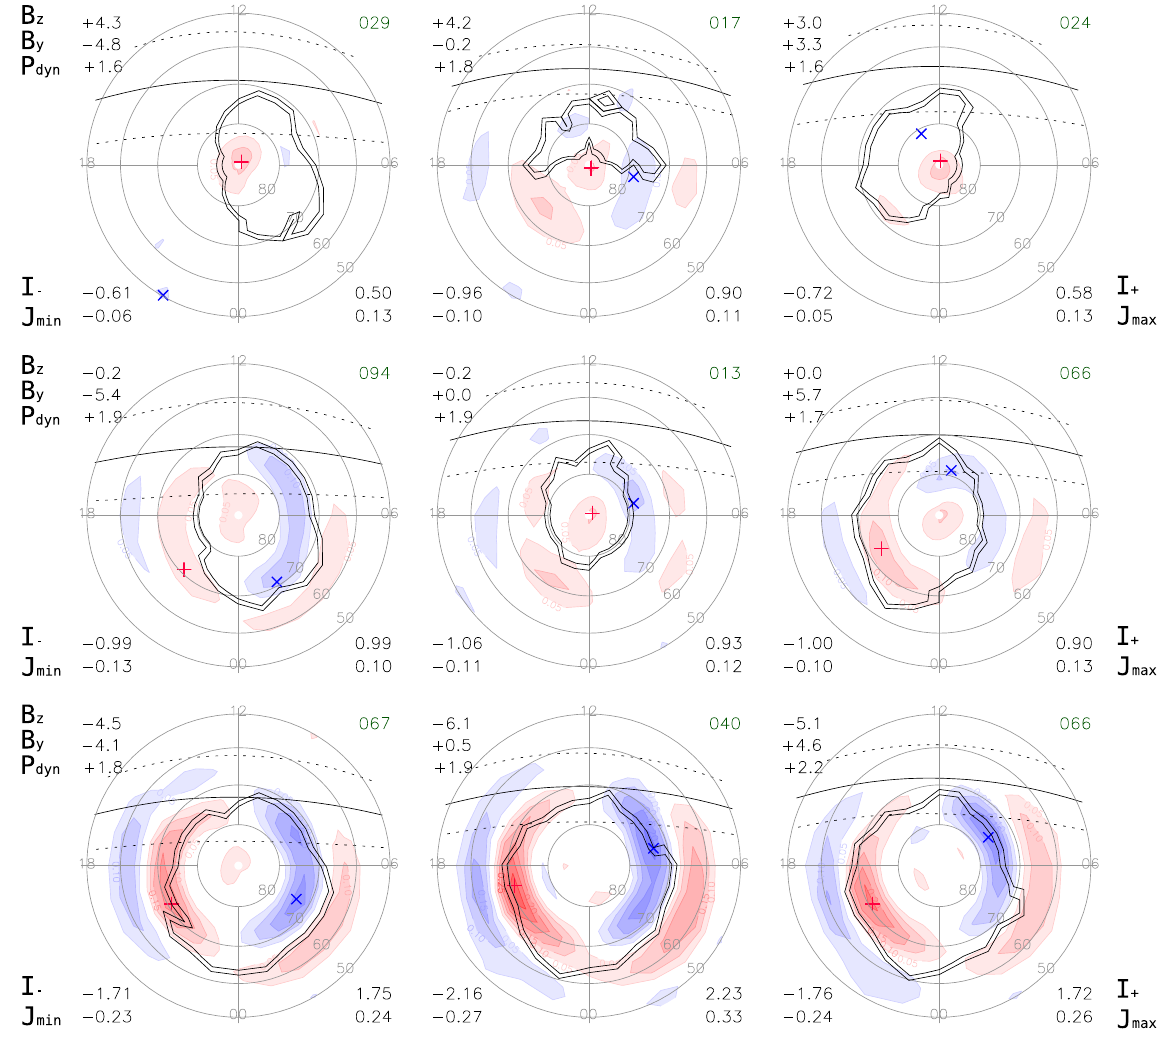
Fig. 8. Southern Hemisphere winter average field-aligned current distributions viewed as seen from above the Northern Hemisphere through the Earth. For full figure description see Fig.